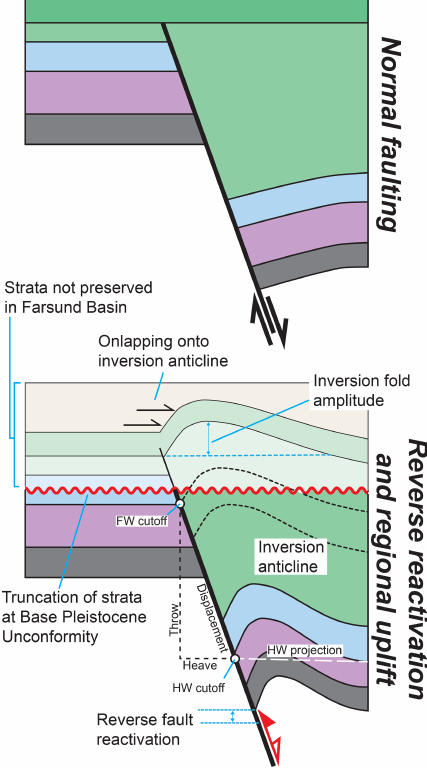
Figure 1. Conceptual model of the reverse reactivation of a previ- ously extensional normal fault. Ductile folding occurs in the hang- ingwall of the fault, producing an anticline displaying a constant amplitude with depth. Strata onlapping onto the limb of the fold at the free surface indicate the age of folding and therefore inversion. In the case of the Farsund Basin, the upper part of the anticline is eroded by the base Pleistocene unconformity, meaning that we have no constraints on the timing of inversion. Projected hanging- wall cutoffs and the footwall cutoff used for throw analyses are also